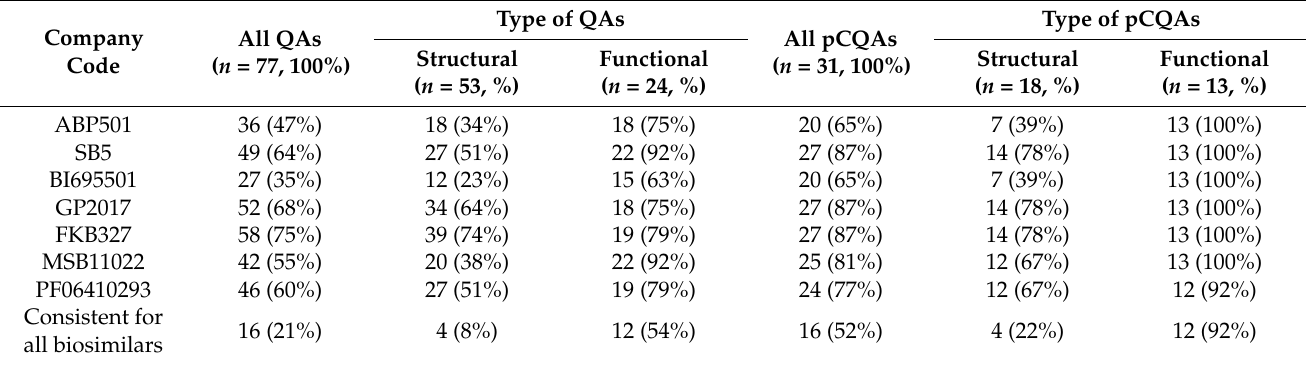
Table 2. Reporting of the quality attributes (QAs) and potentially critical quality attributes (pCQAs) stratified by structural and functional attributes and the company code of adalimumab biosimilars in the included European public assessment reports